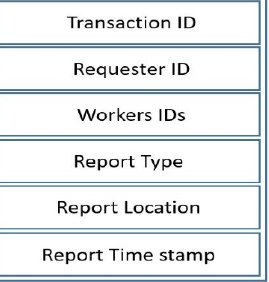
Figure 2. Transaction structure in the proposed system.